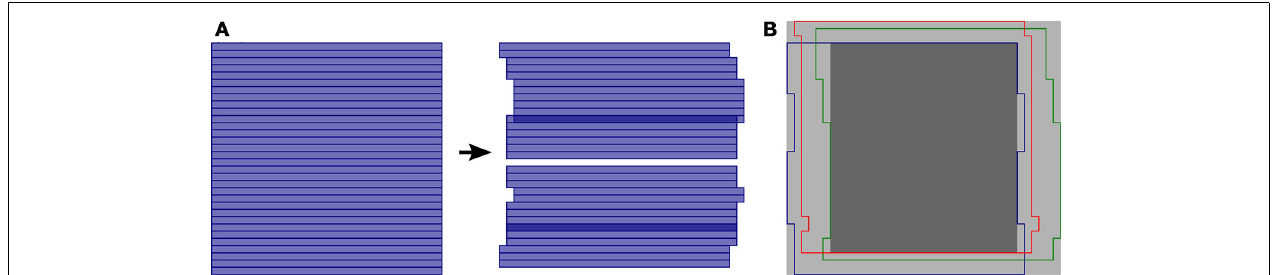
FIGURE 2 | Line-by-line correction of within-frame motion artifacts. (A) Schematic diagram showing a single imaging frame before (left) and after (right) line-by-line motion correction. A separate displacement is calculated for each sequentially acquired line from the laser scanning process. As a result, some pixel locations may be accounted for multiple times (darker blue), while others may not be imaged in a given frame (white gap). (B) Overlay of